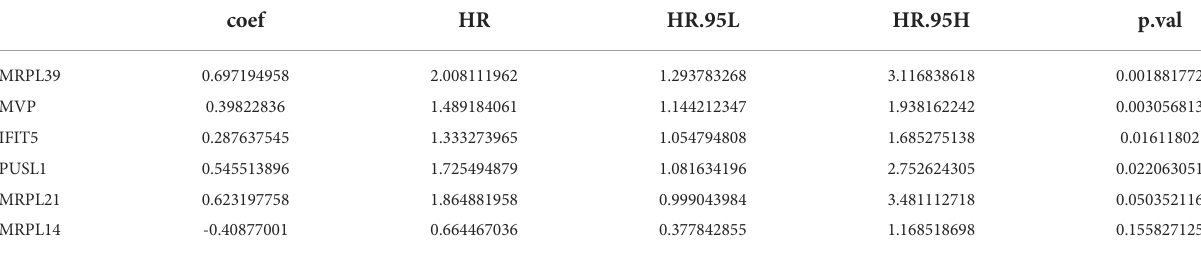
TABLE 2 Multivariate Cox analysis to construction of the risk